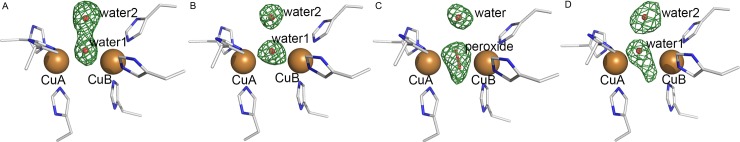
Copper site of the met/deoxy structure of catechol oxidase from Aspergillus oryzae.An Fo−Fc omit map of oxygen species at the copper site is shown in green at the 3σ contour level. A: molecule A, the Cu-Cu distance was 4.3 Å, and the distance between water molecules was 2.5 Å. B: molecule B, Cu-Cu distance was 4.4 Å, and the distance between water molecules was 2.6 Å, C: molecule C, the Cu-Cu distance was 4.4 Å, and the distance from atom O2 of the peroxide moiety to water was 2.5 Å. D: molecule D, the Cu-Cu distance was 4.5 Å, and the distance between water molecules was 2.6 Å.